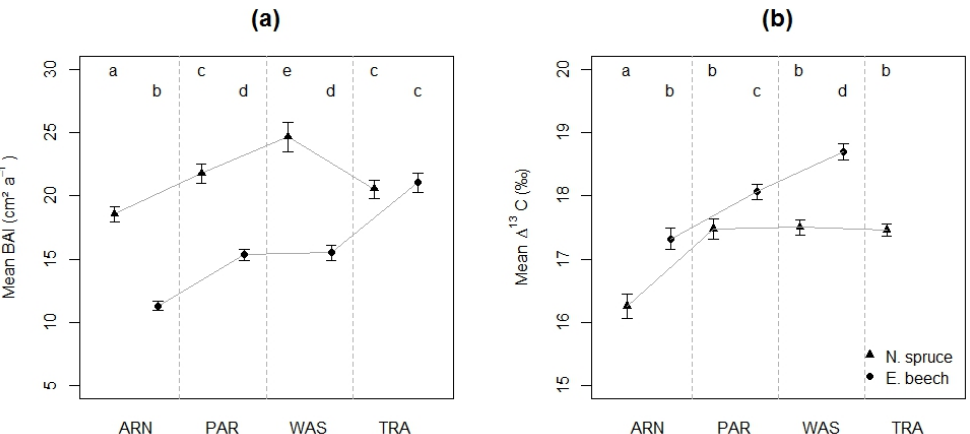
Figure 1. Mean basal area increment ( a ) and Δ 13 C signatures ( b ) of spruce trees (triangles) and beech trees (circles) from the dry site Arnstein to the moist site Traunstein. The means of the years 2000 to 2006 were used. Significances are represented by the letters a to e, calculated with an ANOVA and Tukey HSD (honest significant difference) test for E. beech (European beech) and N. spruce (Norway spruce). The letters represent the significances for spruce trees (above) and for beech trees (below) ( p < 0.05) . The same letters indicate no significant differences.